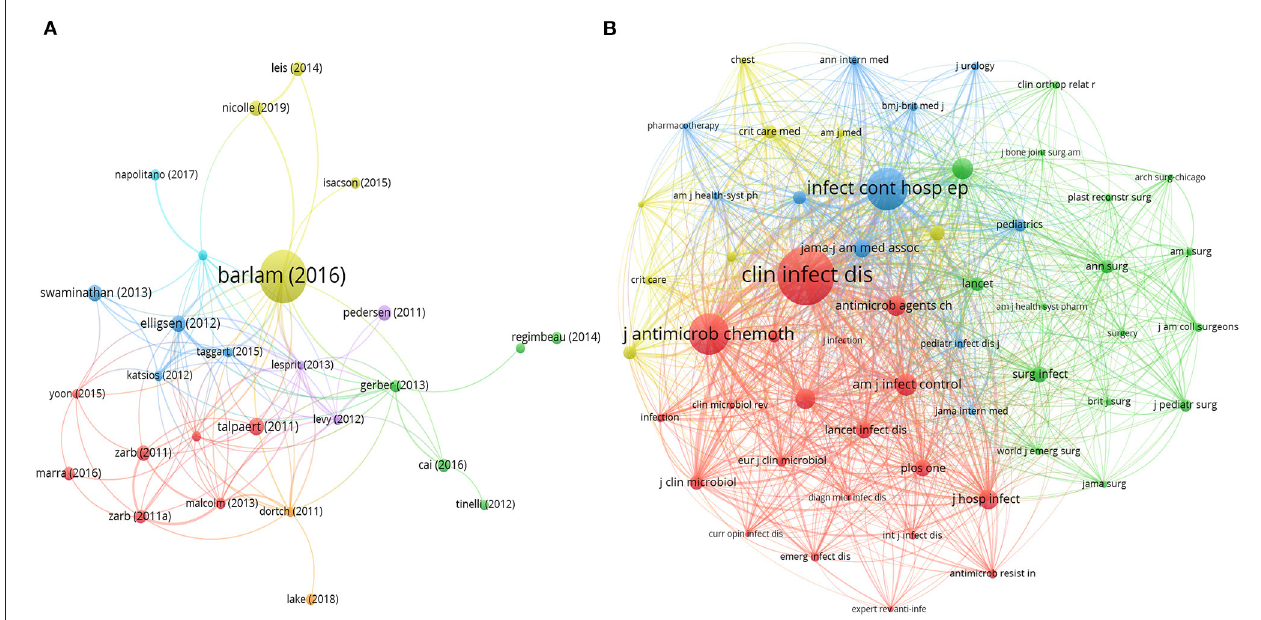
FIGURE 6 | Bibliometric analysis of the bibliographic coupling and co-citation. (A) Bibliographic coupling map of documents, 8 cluster with different color represent the different study area and node indicate different articles included. The largest node was barlam (2016) with 1,109 citations and 55 total link strength in cluster 6; (B) co-citation map of sources, 4 cluster with different color represent source journals included in different study area. The largest cluster (cluster in red, 20 items) included the largest node (“clin infect dis” with 972 citations and 54 links with other source journals). In both figures, the size of the nodes indicates the counts of co-citations and the distance between two nodes represent their correlation.